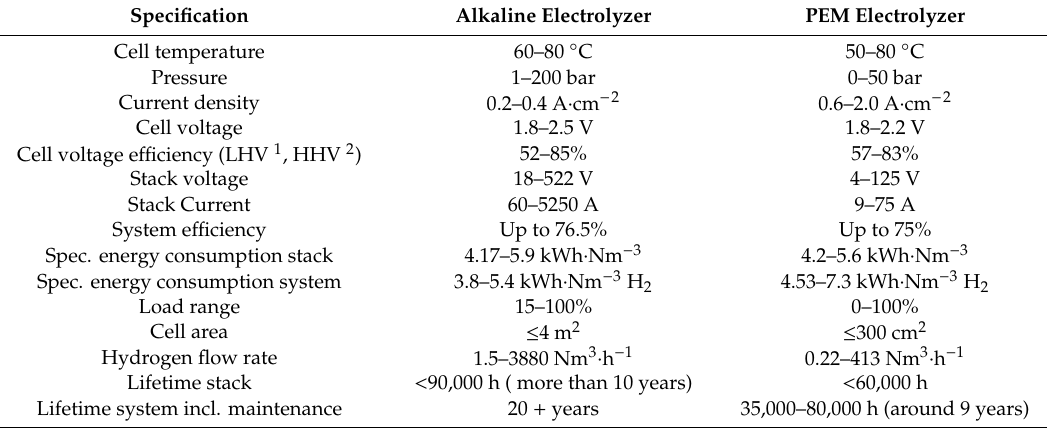
Table 4. State of the art of alkaline and PEM